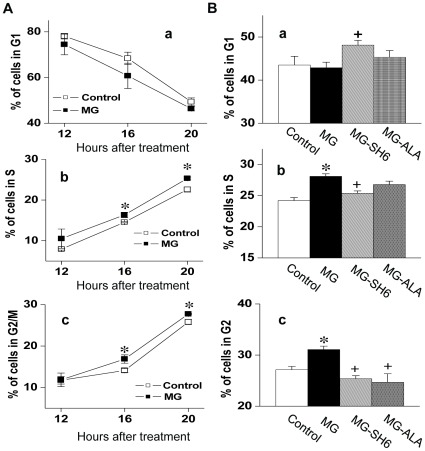
Effect of MG on cell cycle progression of 3T3-L1 cells.After 12, 16, 20 h of MG (10 µM) treatment, cellular DNA content was determined by a flow cytometer (A). The effect of MG with/without SH6 (10 µM) or alagebrium (50 µM) on cellular DNA content is shown in (B). *P<0.05 vs control group; +
P<0.05 vs MG treated group; n = 6 in each group. The indicated percentage of the cell number is average of three experiments. CT: control; ALA: alagebrium.